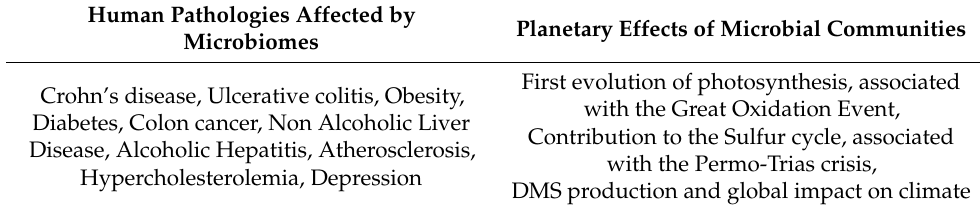
Table 1. Some recognized effects of microbiomes on human health and Earth sustainability. Human Pathologies Affected by Planetary Effects of Microbial Communities Microbiomes First evolution of photosynthesis, associated Crohn’s disease, Ulcerative colitis, Obesity, with the Great Oxidation Event, Diabetes, Colon cancer, Non Alcoholic Liver Contribution to the Sulfur cycle, associated Disease, Alcoholic Hepatitis, Atherosclerosis, with the Permo-Trias crisis, Hypercholesterolemia, Depression DMS production and global impact on